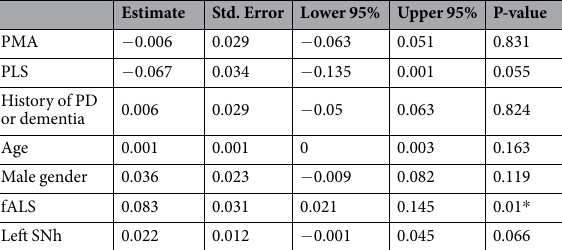
Estimate Std. Error Lower 95% Upper 95% P-value